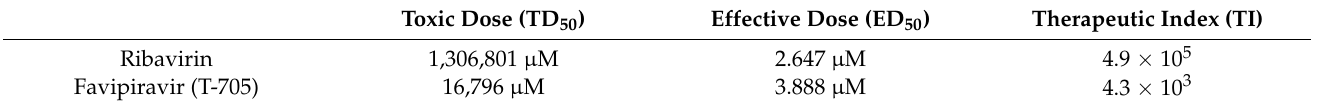
Table 1. Therapeutic index. The therapeutic index (TI) is defined as toxic dose (TD 50 )/effective dose (EC 50 ). Toxic Dose (TD 50 ) Effective Dose (ED 50 ) Therapeutic Index (TI)